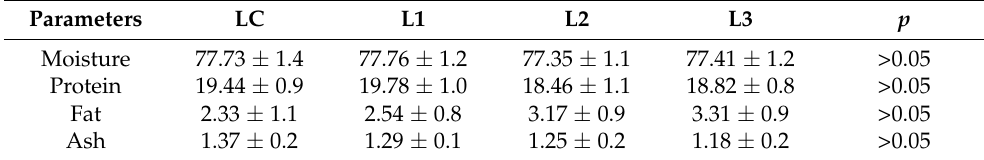
Table 2. Proximate composition (% ww) (mean ± st.dev.) of the fillet of rainbow trout fed with the control diet (LC) and the three experimental diets (L1, L2, L3) at the end of the trial.